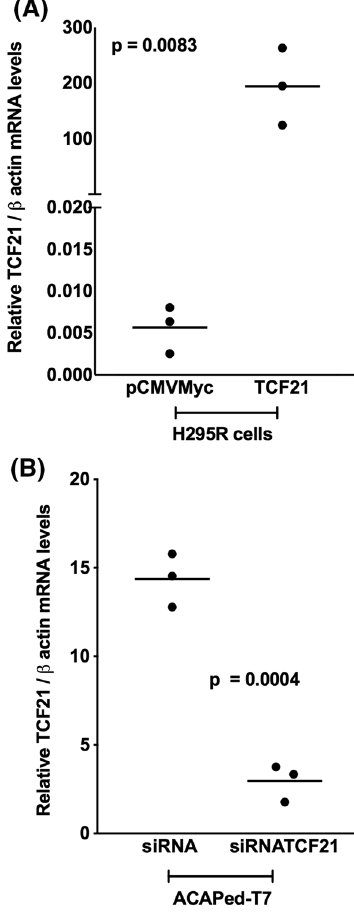
Fig. 2 Modulation of TCF21 expression. A TCF21 overex- pression in H295R transfected with pCMVMycPod1 or empty vector (pCMVMyc); B Inhibi- tion of TCF21 in ACAPed-T7 cells using siRNATCF21 or con- trol (siRNA). The experiments were performed in triplicate and repeated three times. The results were expressed as the mean ± SD.